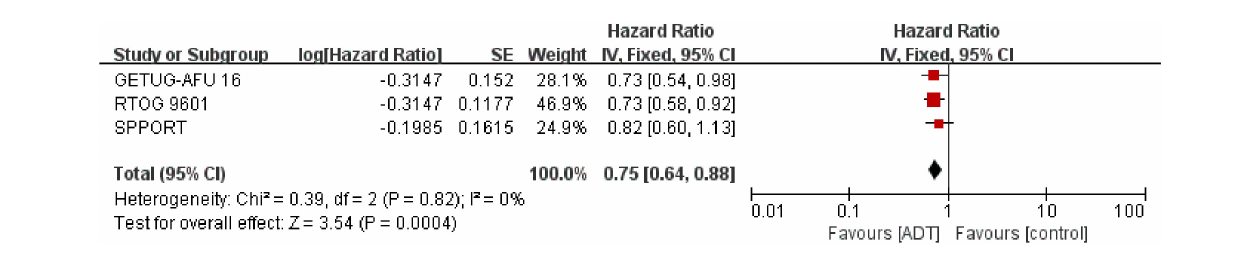
FIGURE 3 Assessment of Metastasis Free Survival. The diamond indicates best estimate of the true (pooled) outcome (with width indicating 95% CI); HR, hazard ratio; experimental stands for salvage radiotherapy combined with endocrine therapy; control stands for salvage radiotherapy alone. Since there is no heterogeneity, a fi xed-effects model is used.